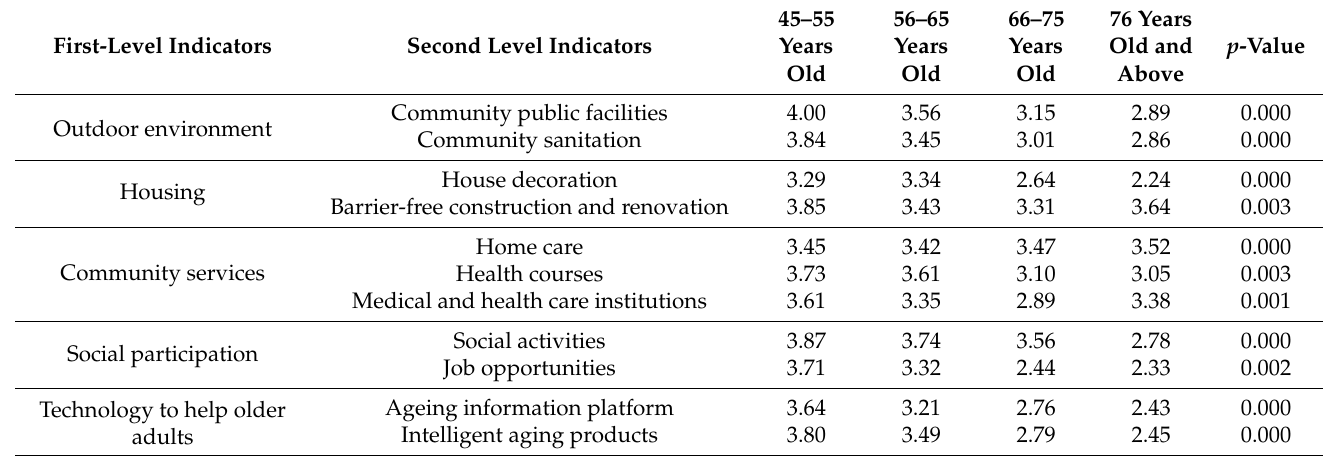
Table 11. Kruskal–Wallis test for different age groups.